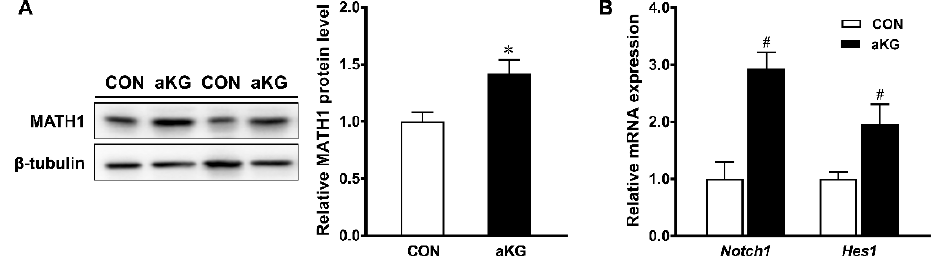
Figure 5. Alpha-ketoglutarate (aKG) supplementation upregulates signaling transcription factors committing cells to the secretory cell lineage. ( A ) MATH1 immunoblotting; ( B ) mRNA expression of Notch1 and Hes1 . CON: control mice without aKG; aKG: mice receiving 1% aKG in drinking water. Mean ± SEM, n = 7–8 mice per group. #: p < 0.10, *: p < 0.05.